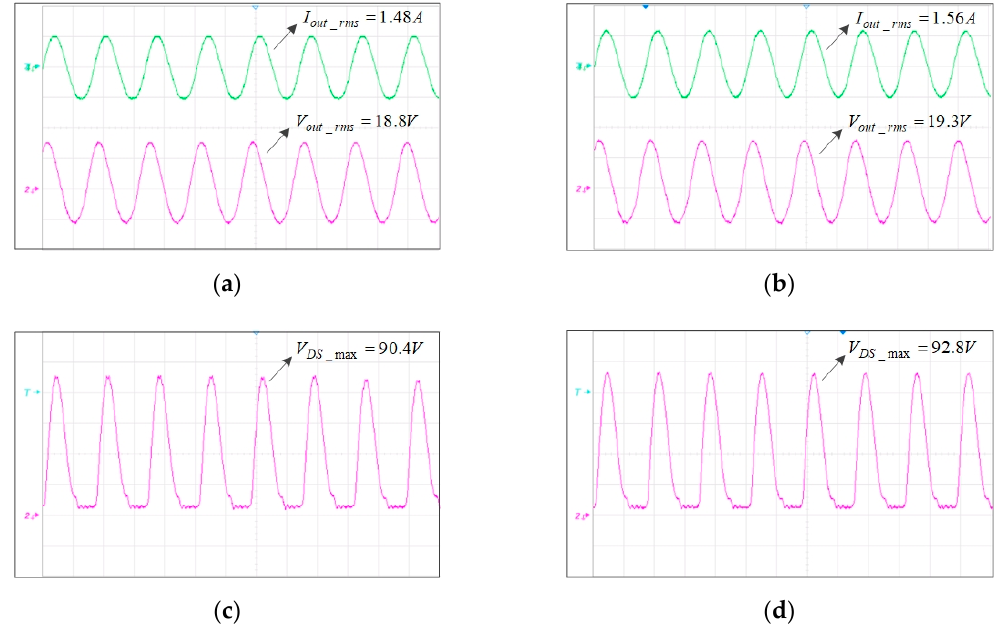
Figure 7. ( a ) Load current and voltage waveform of RFC before optimization; ( b ) load current and voltage waveform of RFC after optimization; ( c ) drain-source voltage waveform of PCL before optimization; ( d ) drain-source voltage waveform of PCL after optimization.